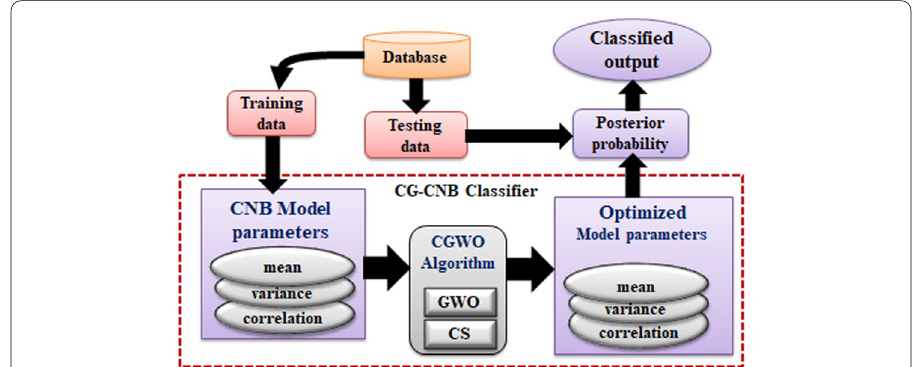
Fig. 1 Control and Data Flow of CGCNB-MRP